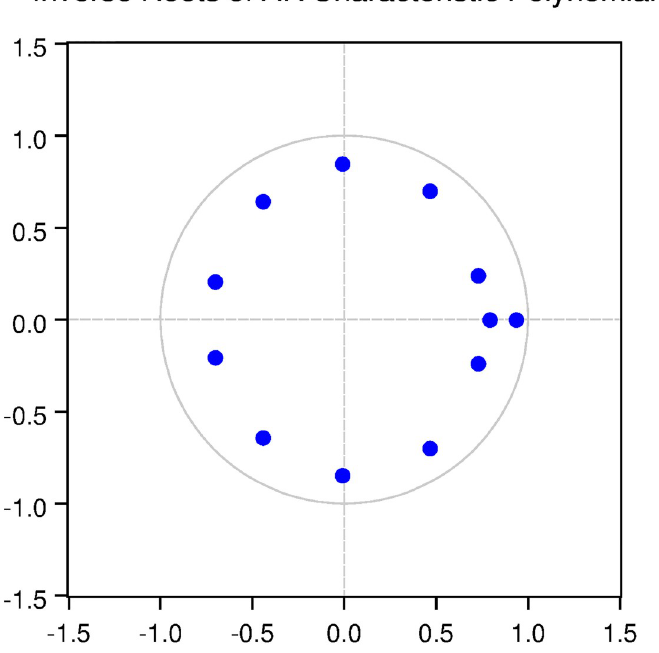
Fig 5. Inverse roots of AR characteristic polynomial for Australian data when P = 4 (proposed model).